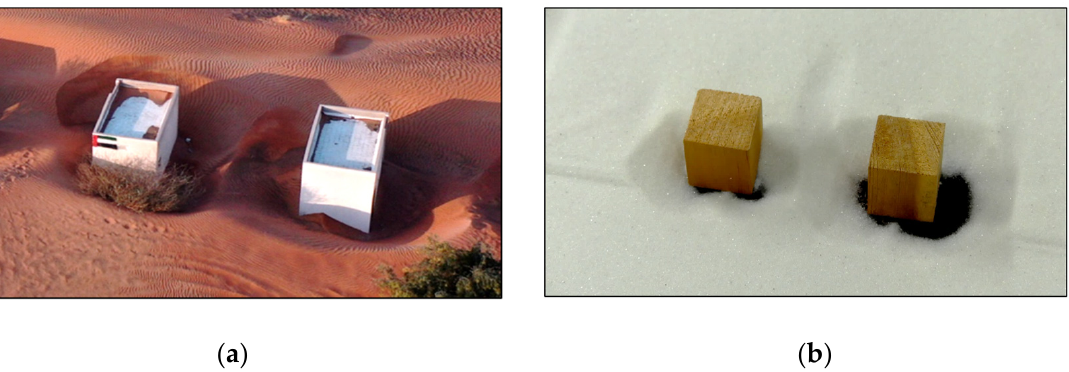
Figure 14. Sand pattern around two cubic buildings in ( a ) the town of Al-Madam (photo: G. Ca- cace/AFP) and ( b ) simulated in the wind tunnel (photo: D. Goossens).